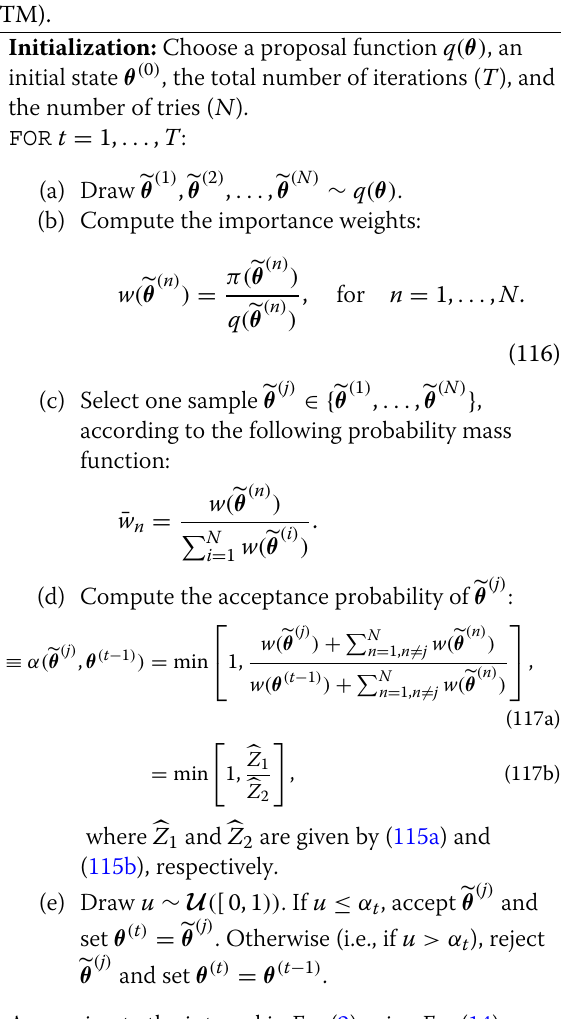
Algorithm 22 Independent Multiple Try Metropolis